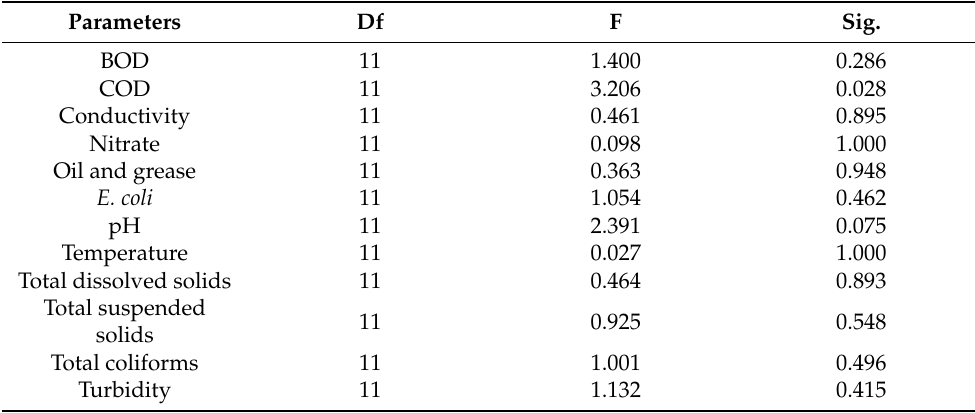
Table 2. Physicochemical parameters ANOVA for Ngong River for wet and dry